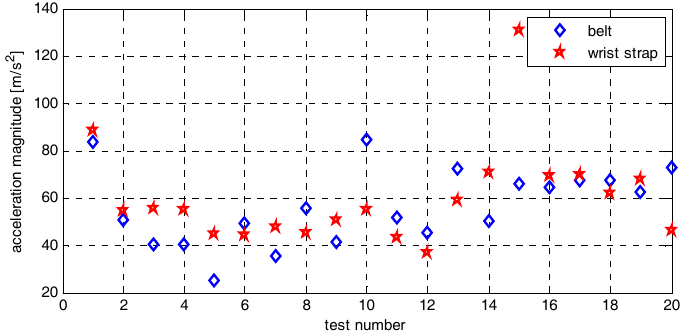
Figure 20. Acceleration magnitude maxima achieved during tests.